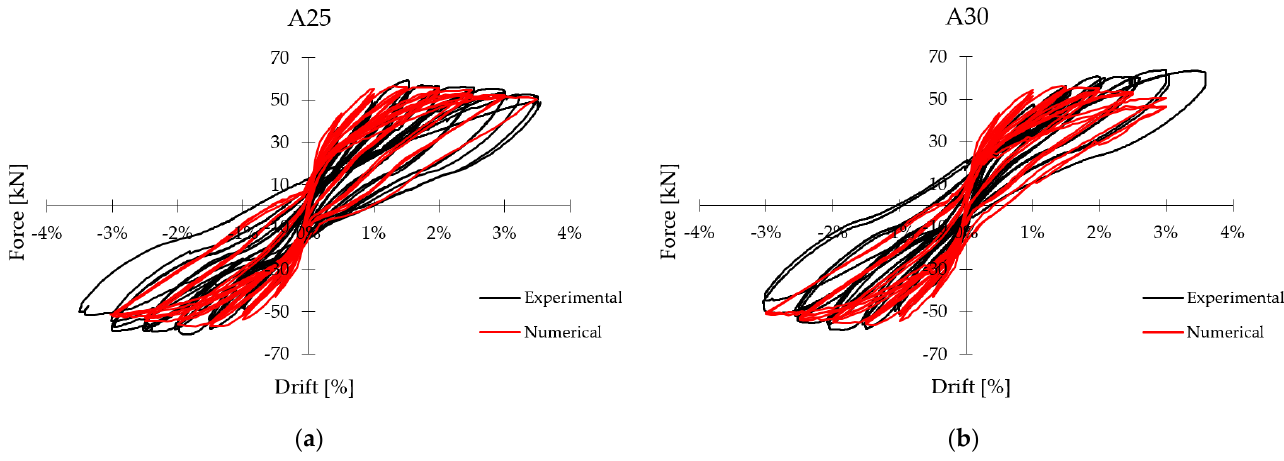
Figure 12. Comparison between experimental and numerical response, un-corroded columns. ( a ) specimen B25, ( b ) specimen B30.